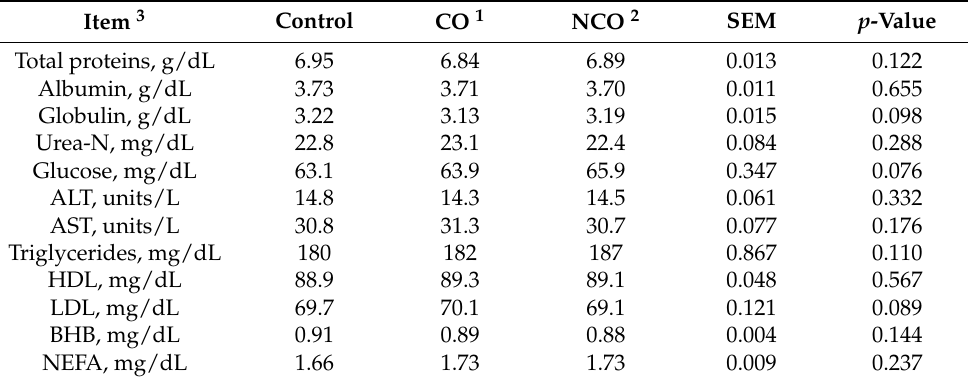
Table 3. Effect of the supplementation of raw and nanoemulsified corn oil on blood measurement of dairy